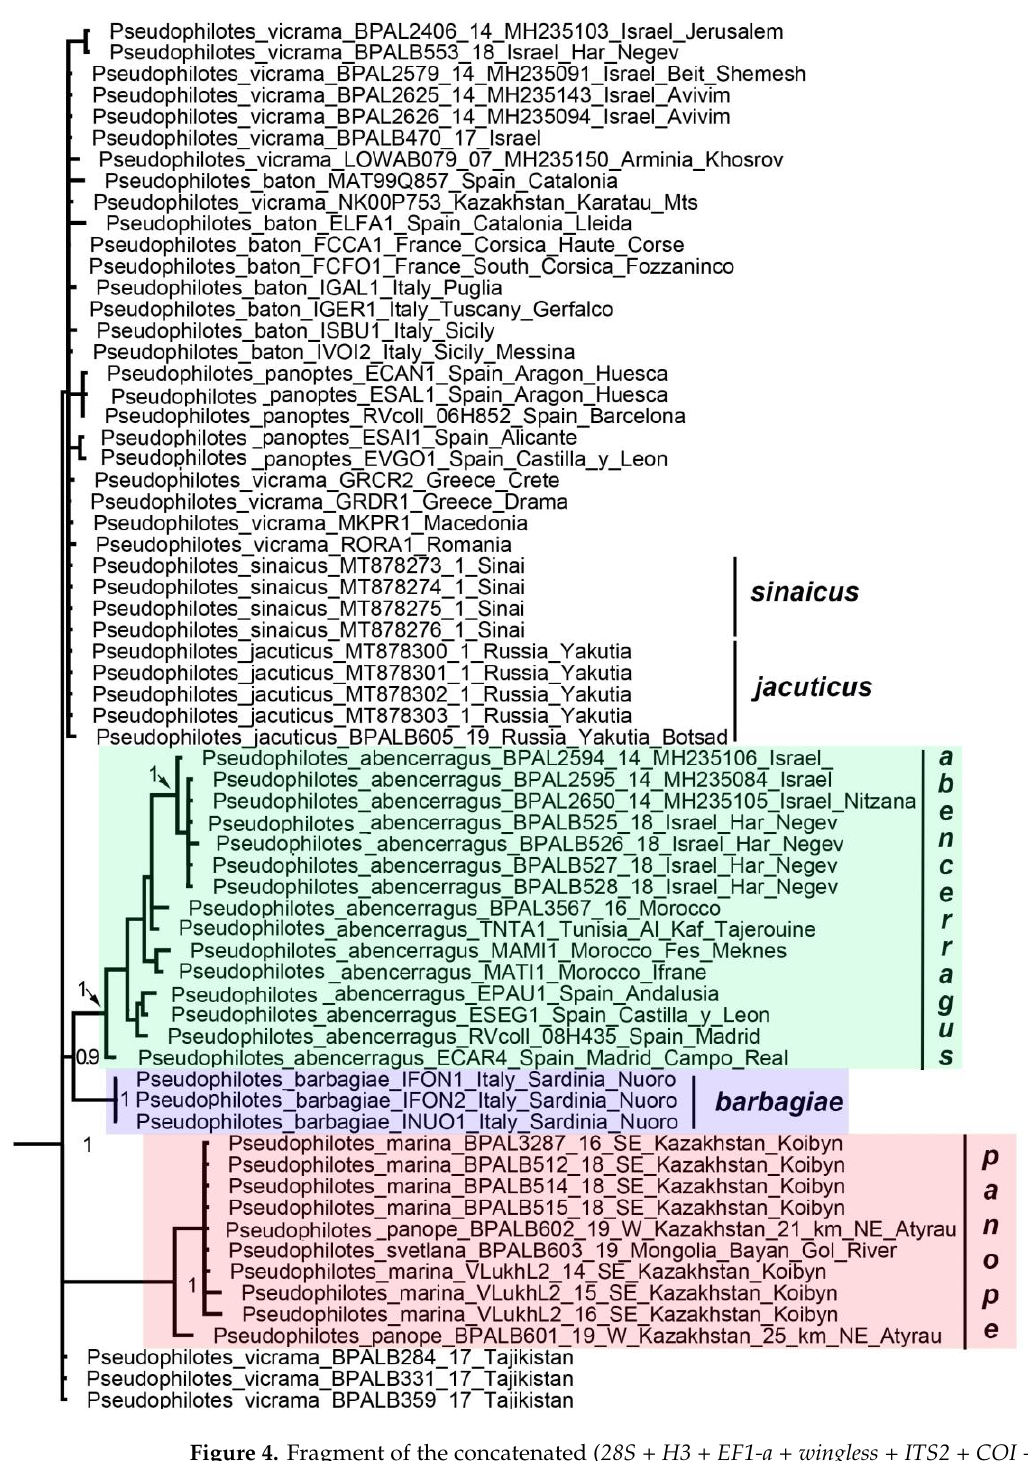
Figure 4. Fragment of the concatenated ( 28S + H3 + EF1-a + wingless + ITS2 + COI + COII ) BI tree. The subgenus Pseudophilotes ( Pseudophilotes ) (= Inderskia , syn. nov .) is shown. Posterior probabilities are indicated at the nodes.